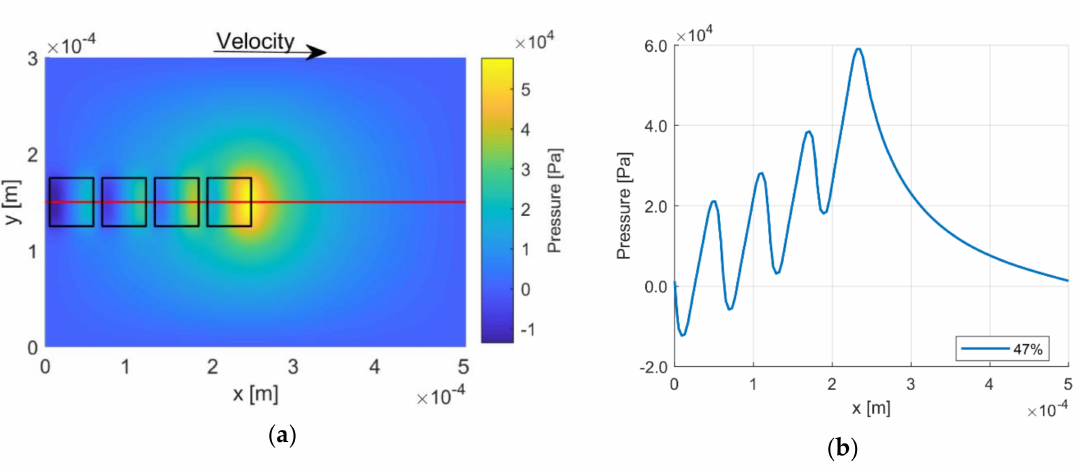
Figure 18. ( a ) Pressure contour of a partial texturing configuration realized by square dimples with side 50 µ m and depth 10 µ m. Gap 10 µ m, sliding velocity 5 m / s. ( b ) Pressure profiles calculated along the dimples median line, textured portion of 47%. Square dimples with side 50 µ m and gap 10 µ m, sliding velocity 5 m / s.